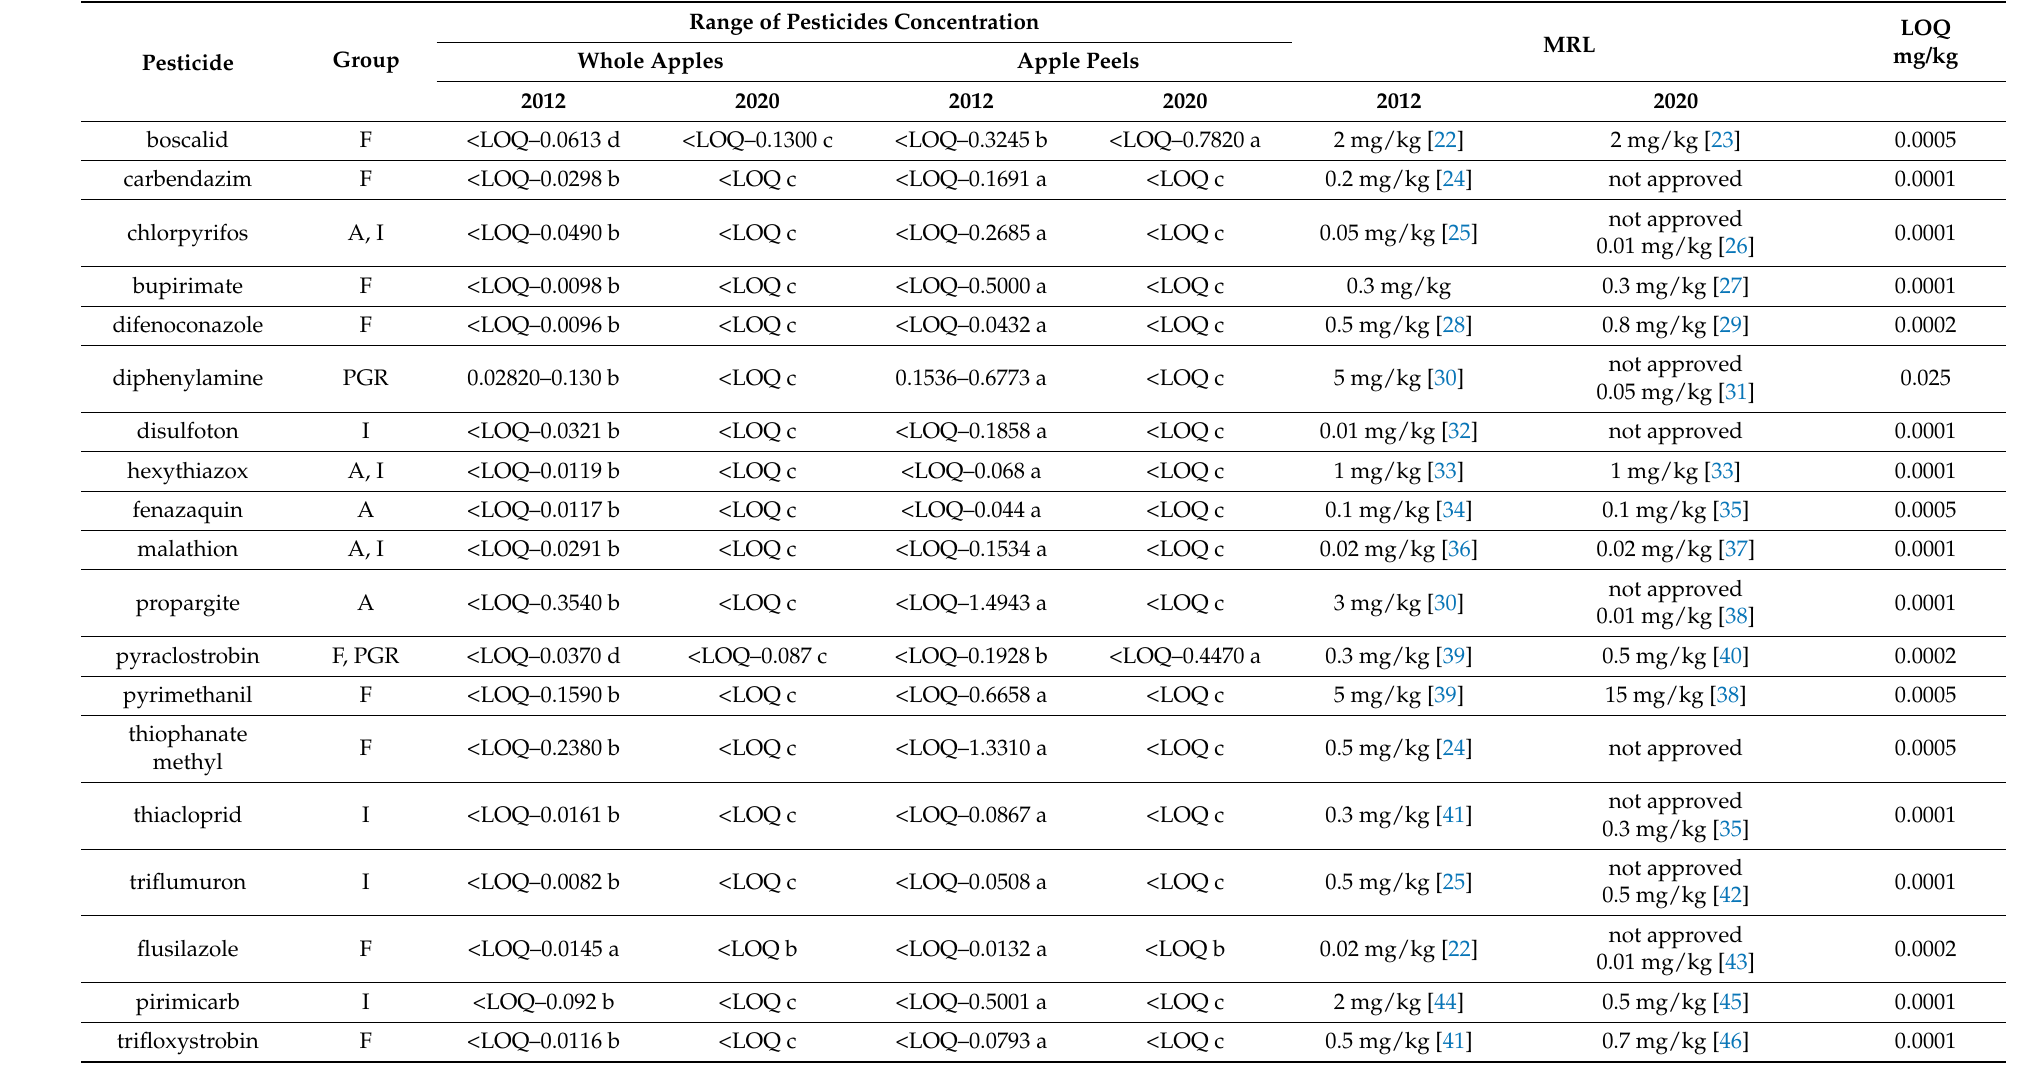
Table 1. Levels of individual pesticides in apples and the values of